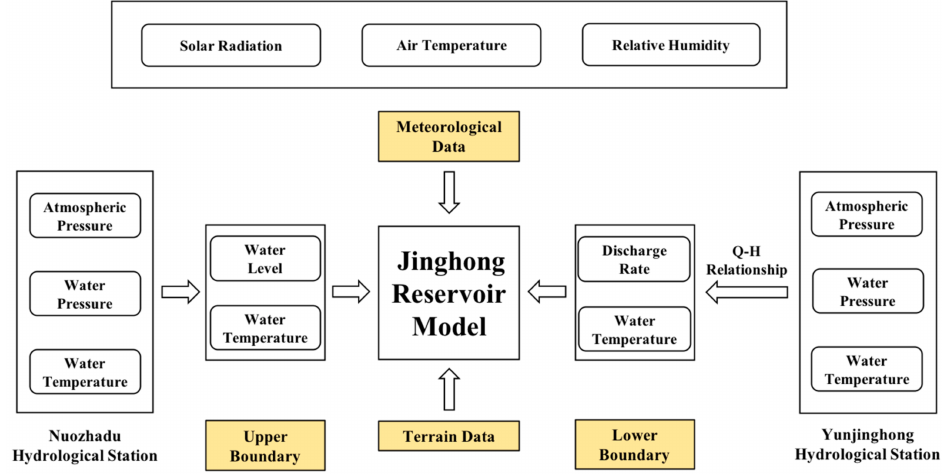
Figure 6. Flowchart of the Jinghong Reservoir model